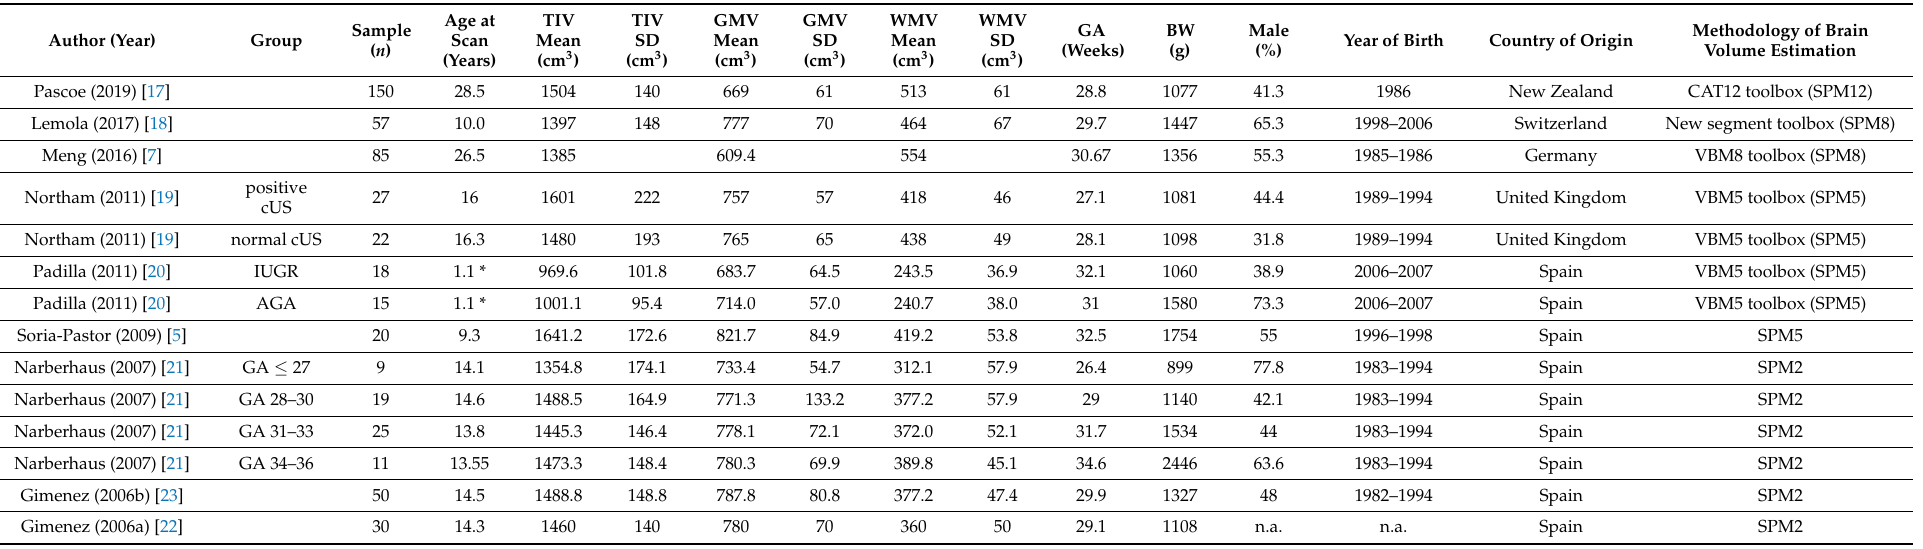
Table 1. Characteristics of preterm studies